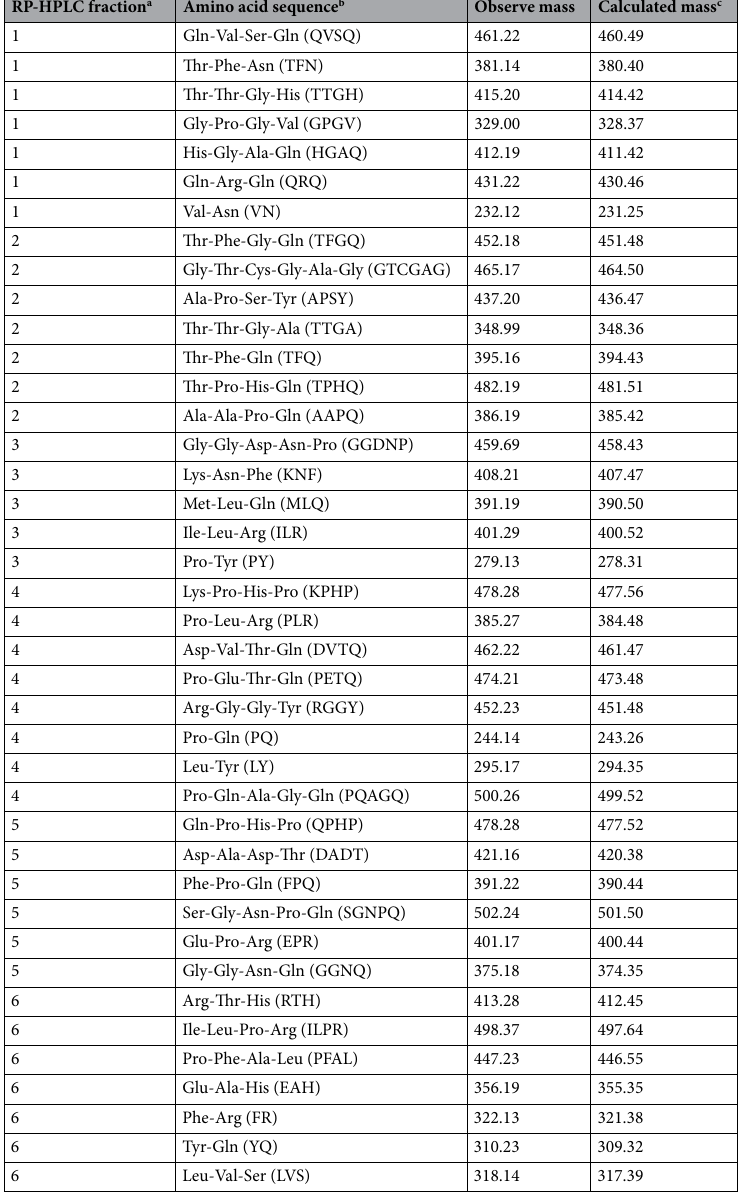
Table 3. Identification of peptides by quadrupole time-of-flight mass spectrometry (Q-TOF2) of WOP fractions collected from reversed-phase high-performance liquid chromatography (RP-HPLC). a Fractions are indicated in Fig. 3 b Three-letter representations of amino acids, and single-letter representations in parentheses. c Average